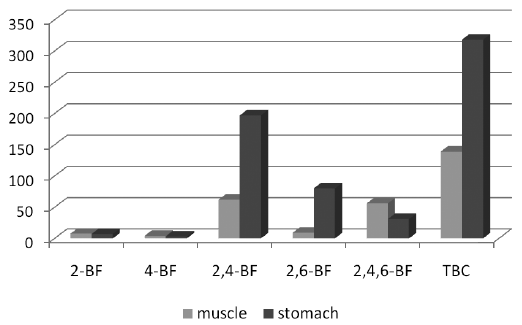
Fig. 4 – Average bromophenol concentrations and TBCs in the muscle and stomach of O. chrysurus